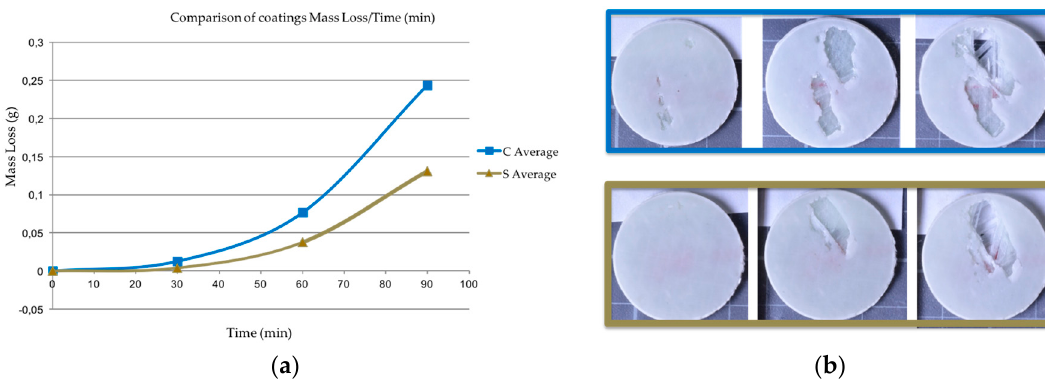
Coat 2 (Semi-cured, S in Green); ( b ) Images of surface and delamination damage after 30, 60 and